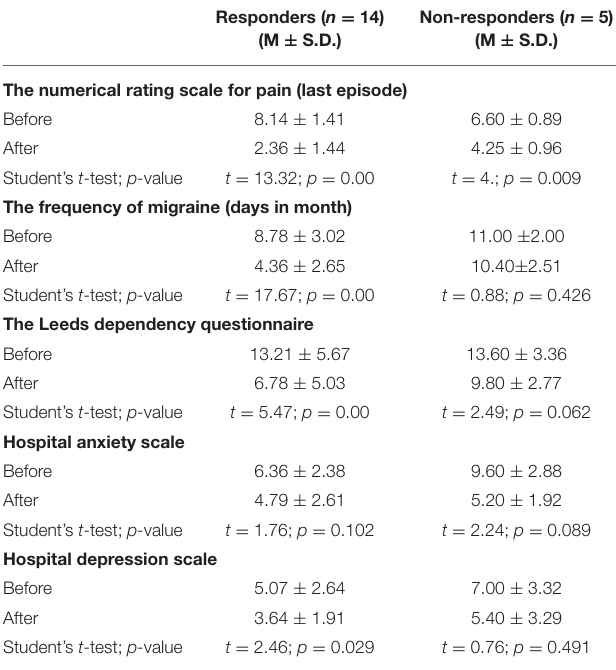
TABLE 3 | Test battery data of the responders and the non-responders to one course of TMS therapy. Responders ( n = 14) (M ±